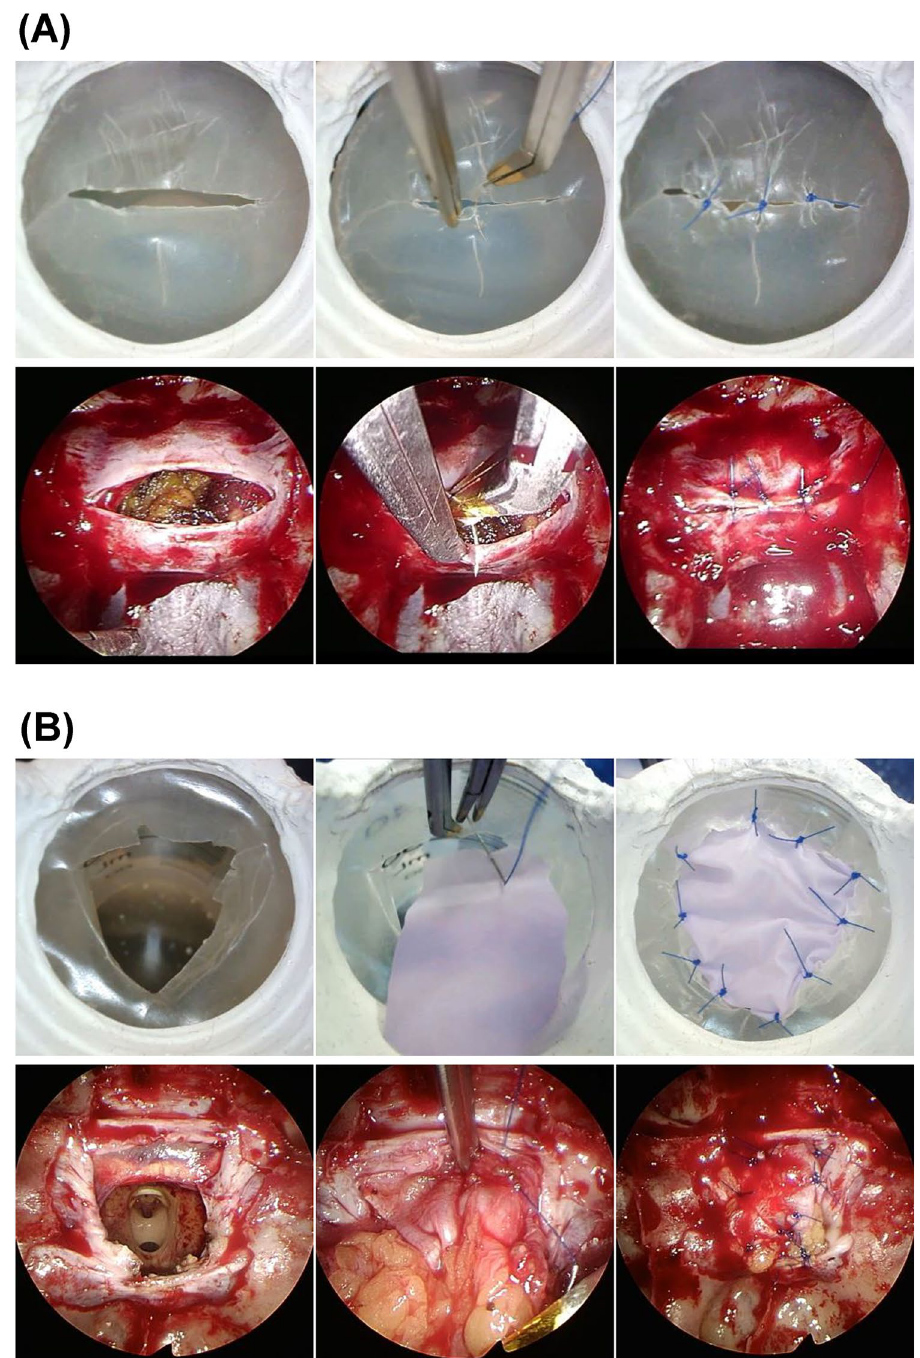
Figure 5. Actual training. Upper panels, the images of practicing; Lower panels, the surgical field envisioned. ( A ) Suture of the pituitary dura mater incised in a single horizontal letter. ( B ) Suture of a large incision of pituitary dura mater using a free